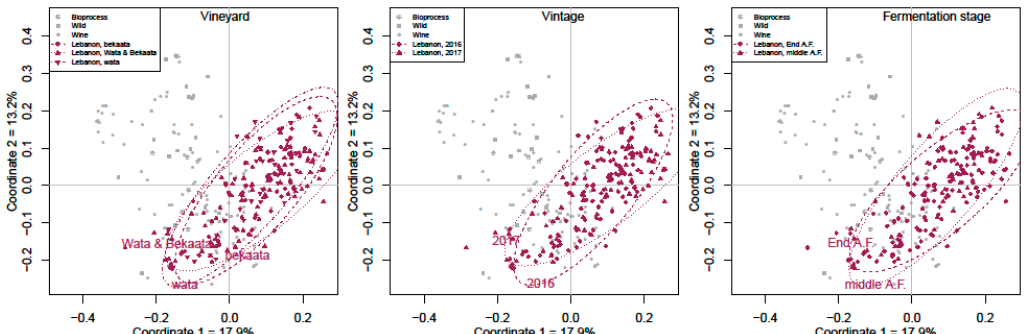
Figure 3. The MULTIDIMSCALE factors. Multidimensional scaling of the Lebanon ‘Merwah’ S. cerevisiae wine strains according to vineyard, vintage and fermentation stage. Dotted circle regroup strains population refer to their factorial group.